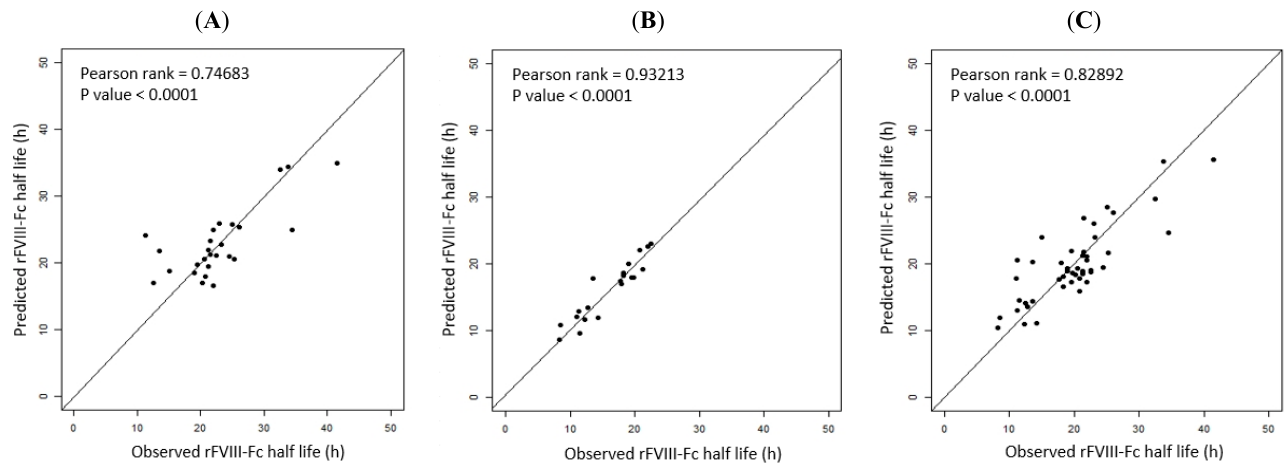
Figure 4. Correlation between the observed and predicted rFVIII-Fc half life values in the devel- opment cohort: ( A ) for non-O group PwHA (n = 26) ( p -rank = 0.74683, p -value < 0.0001); ( B ) for O group PwHA (n = 20) (P-rank = 0.93213, p -value < 0.0001); ( C ) for the entire cohort of PwHA (n = 46) (P-rank = 0.82892, p -value < 0.0001). The drawn lines show the best fit by univariate linear regression.